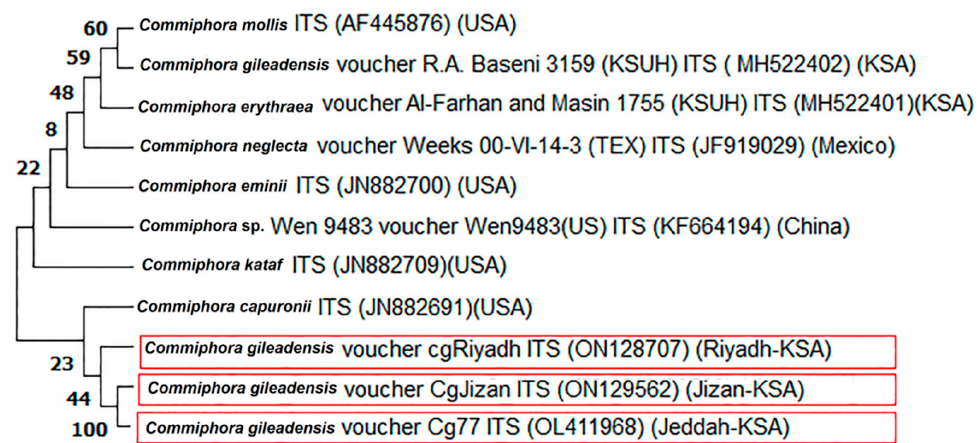
Figure 1. Phylogeny tree for C. gileadensis accessions in KSA from ITS sequences (highlighted in red) compared with other relatives of the closest species obtained from GenBank from different localities. Bootstrap tests were performed with 2000